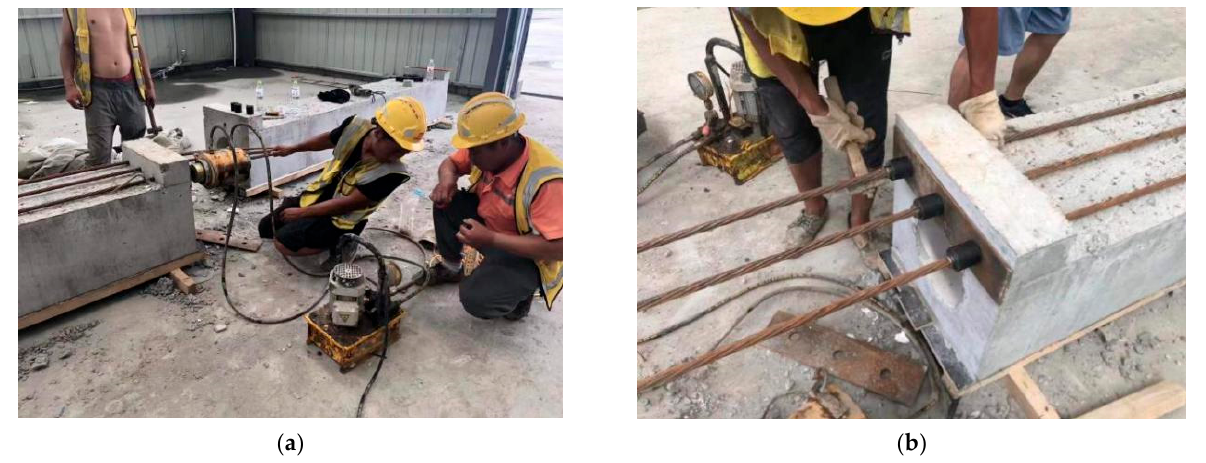
Figure 5. Field photograph of steel strands: ( a ) tensioning, ( b )